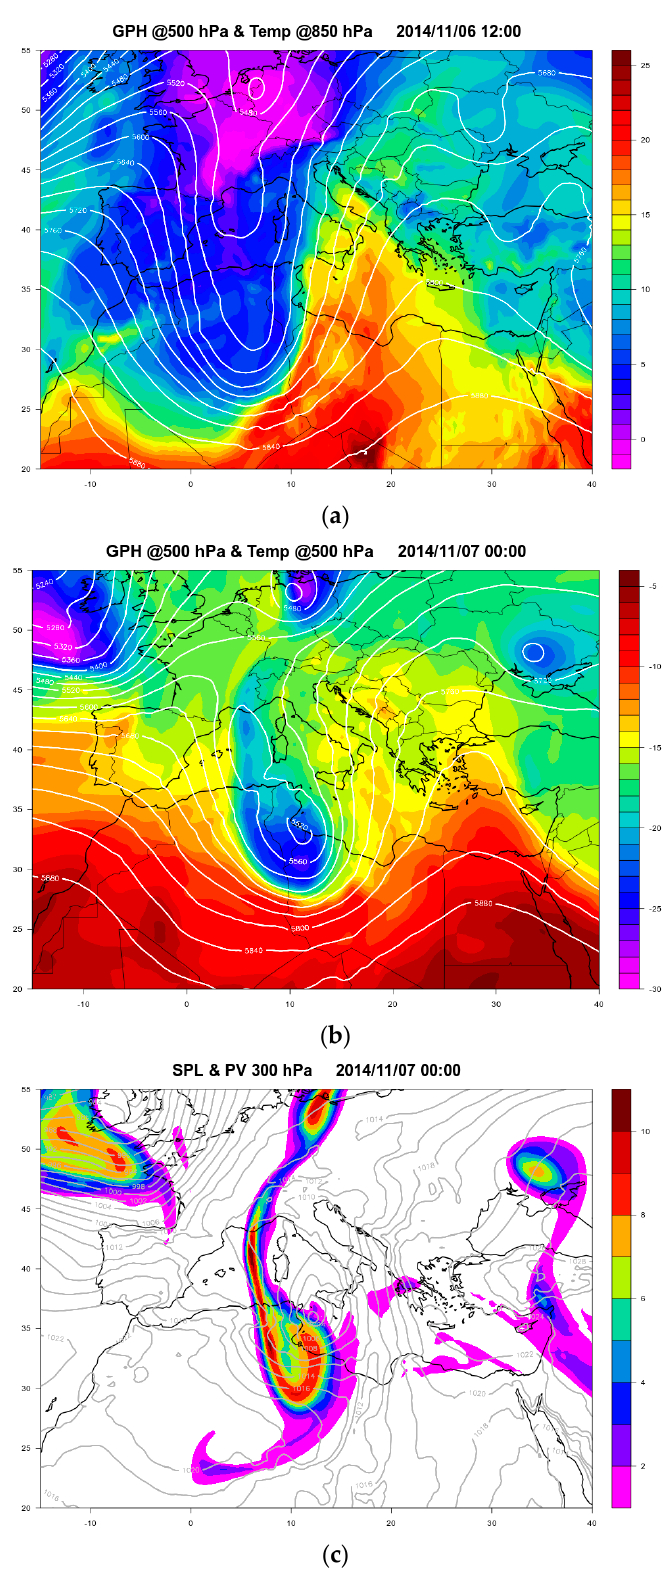
Figure 3. ( a ) Geopotential height at 500 hPa (contour, gpm) and temperature at 850 hPa (shaded, °C) at 12:00 UTC, November 6th, 2014; ( b ) geopotential height (contour, gpm) and temperature (shaded, °C) at 500 hPa at 00:00 UTC, November 7th, 2014, and ( c ) sea-level pressure (contour, hPa) and potential vorticity at 300 hPa (shaded, PVU) at 00:00 UTC, November 7, 2014. Data are based on ERA5 reanalysis